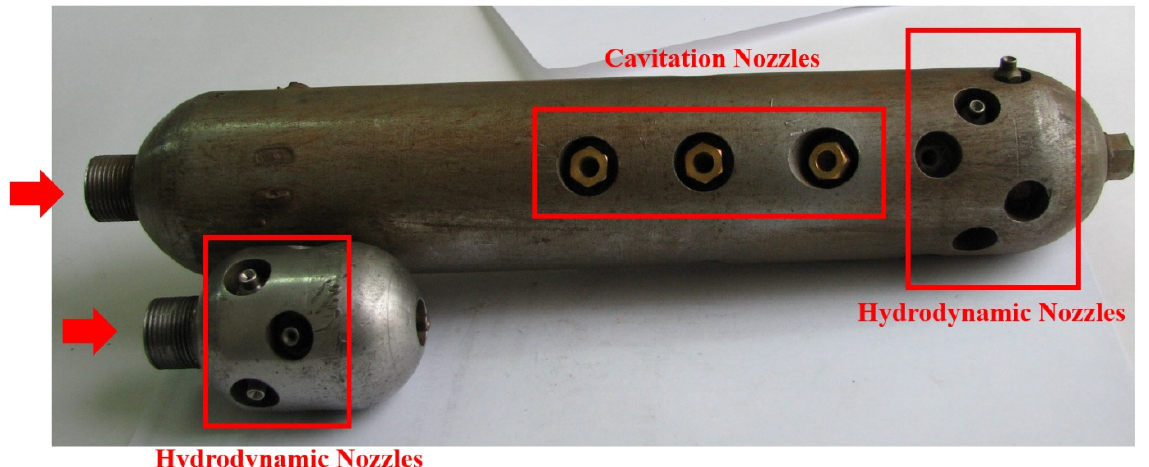
Figure 2. Geometry of nozzle holders.